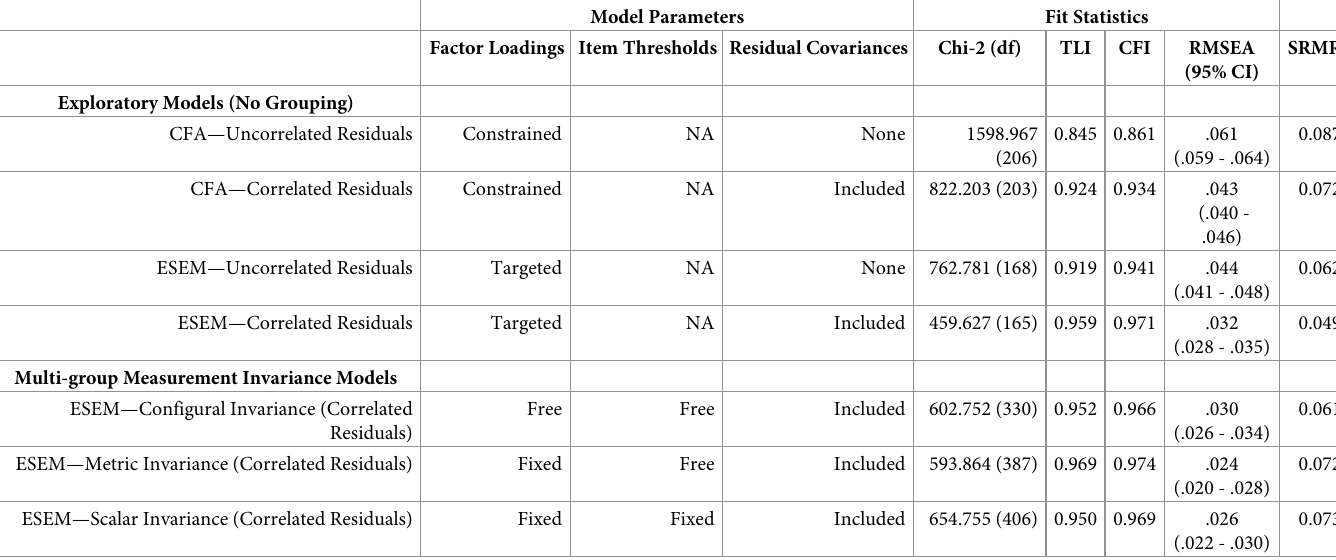
Table 3. Exploratory models, parameter constraints, and fit statistics for increasingly restrictive measurement invariance